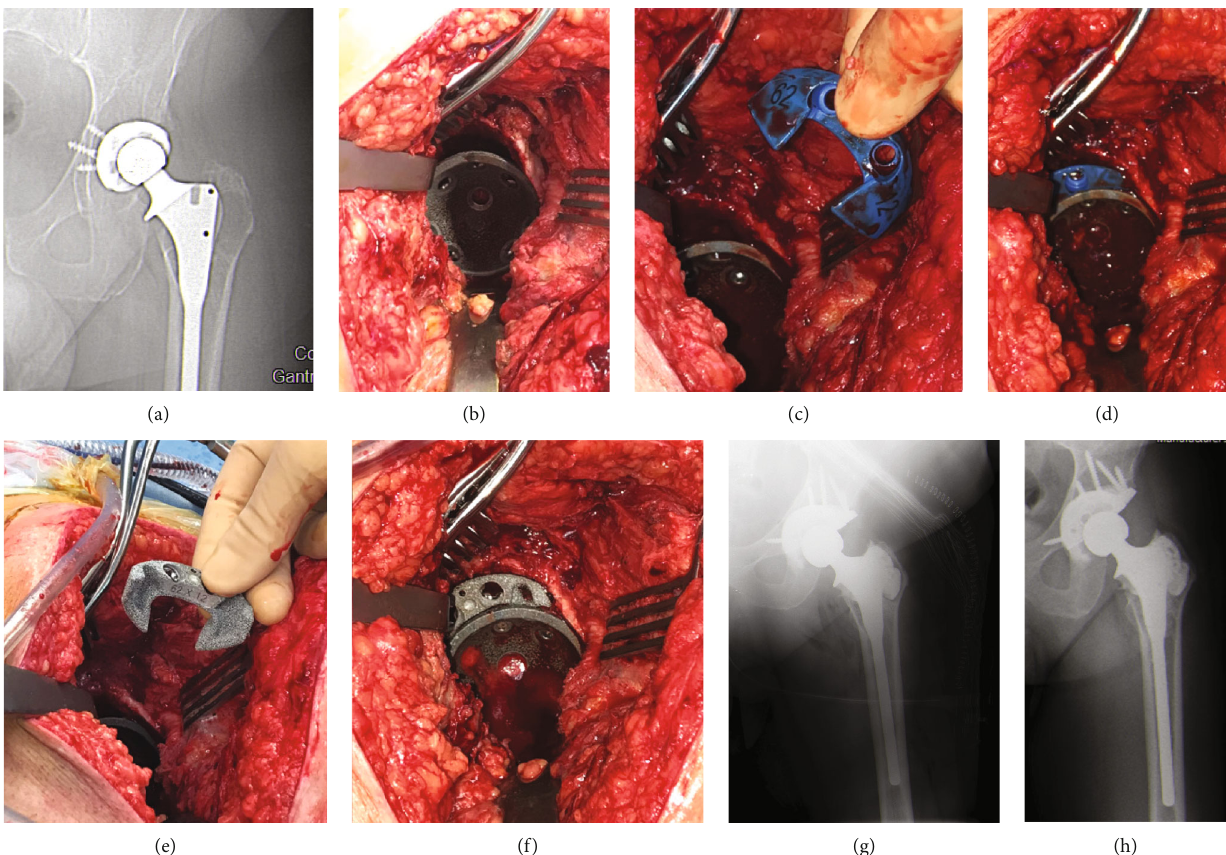
Figure 3: (a) Preoperative X-ray. (b) Intraoperative image after insertion of the cup. (c) and (d) Plani fi cation of augment size with trial implants. (e) and (f) Insertion of augment implant ( “ staple ” type). (g) Postoperative X-ray. (h) Two-year follow-up